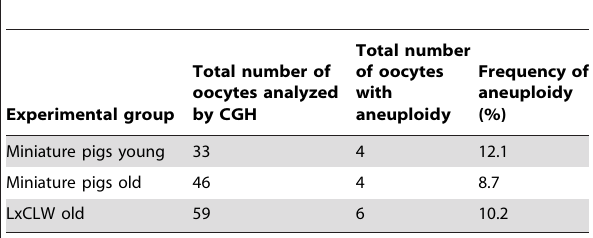
Table summarizing the frequency of aneuploidy in oocytes isolated from various age categories. The total number of oocytes analyzed by comparative genomic hybridization (CGH) together with the number of oocytes with incorrect chromosomal counts and their frequency per group is indicated. LxCLW stands for crossbred of Landrace and Czech Large White pigs.